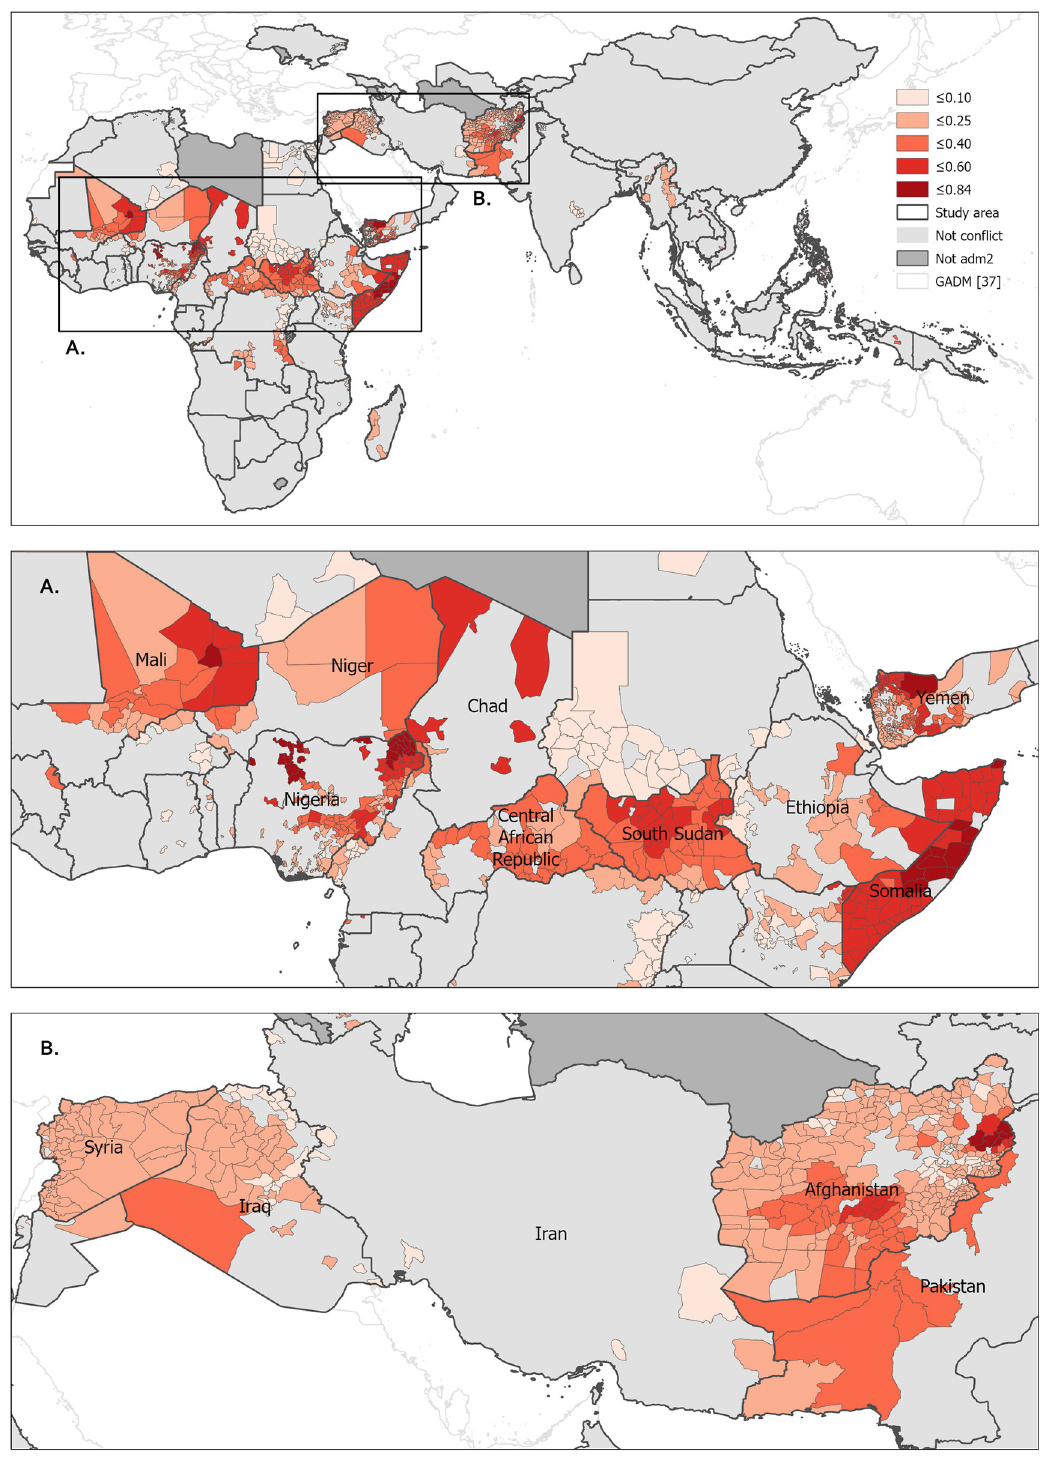
Fig 3. Proportion of children under 1 years of age in conflict-affected areas (broad definition) estimated to have not received the first dose of the DTP vaccine in 2019 at GADM administrative level 2 [31, 37] for Africa and Asia, with close ups shown for northern sub-Saharan Africa (A), and the Middle East/West Asia region (B).